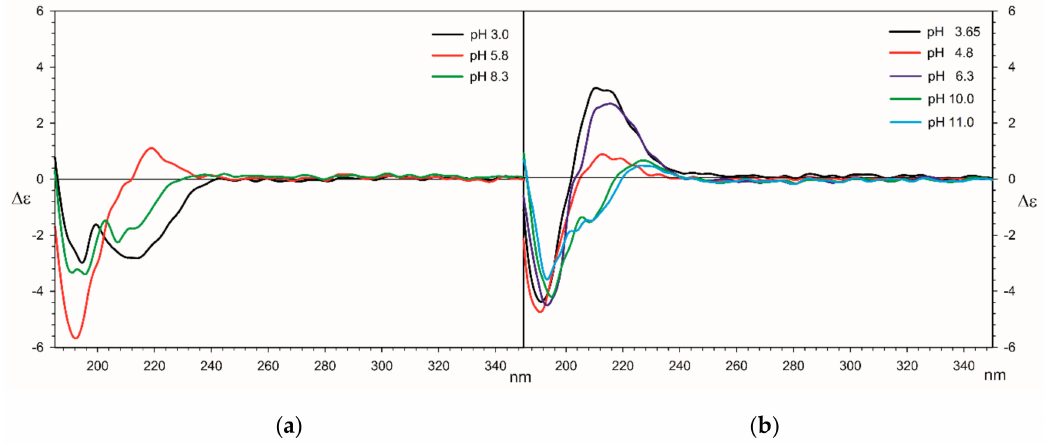
Figure 6. The Circular dichroism (CD) spectra of the systems (a) La / Tar; (b) Ho /